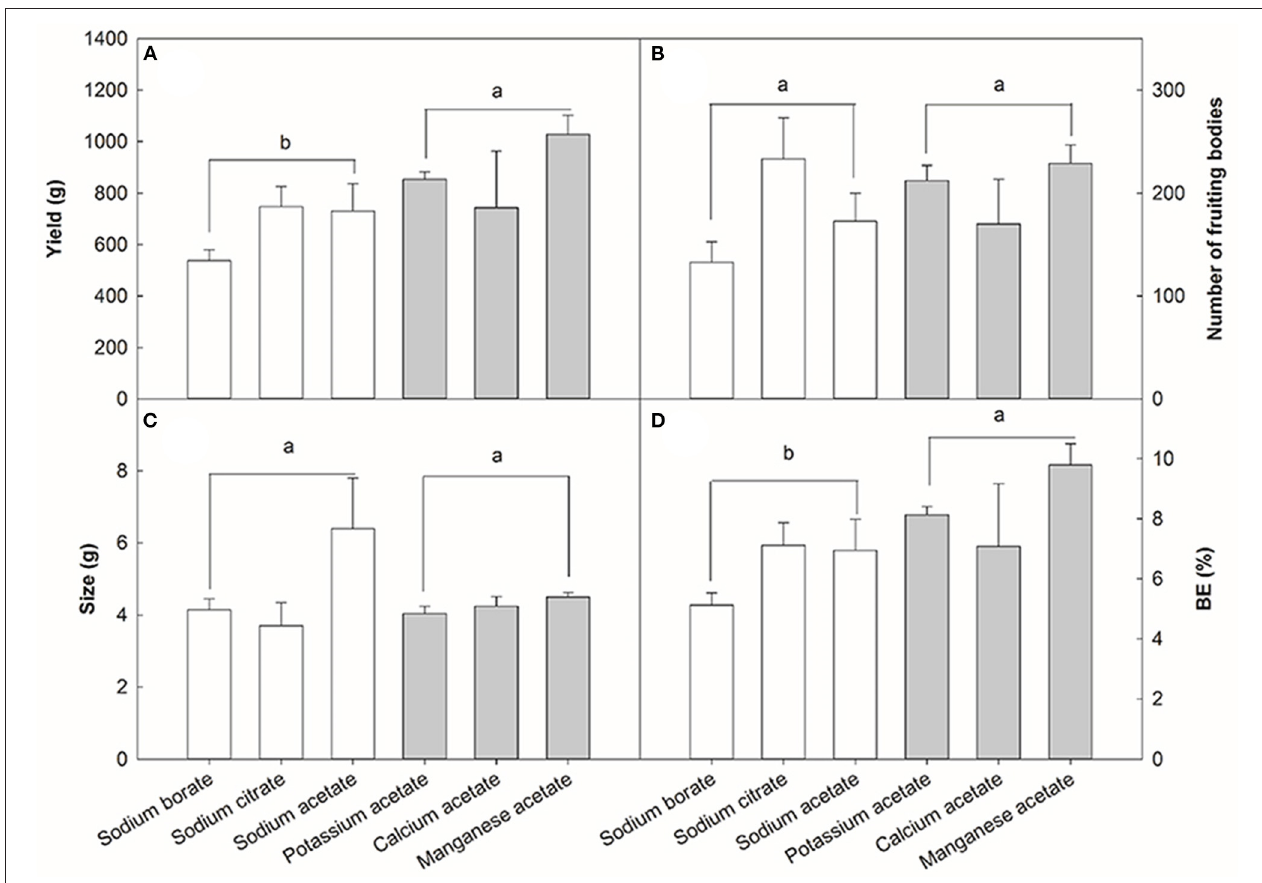
FIGURE 6 | Effect of three anions and cations on the yield (A) , number of fruiting body (B) , size (C) , and BE (D) of V. volvacea . Sodium acetate, sodium citrate, and sodium borate were used as the cations sources, while potassium acetate, calcium acetate and manganese acetate were used as the anions sources. Sodium acetate was used as an internal control. Bars indicate the mean ± SD, while different letters indicate significant differences by Tukey’s post-hoc test between anion and cation treatments, n = 3 for each